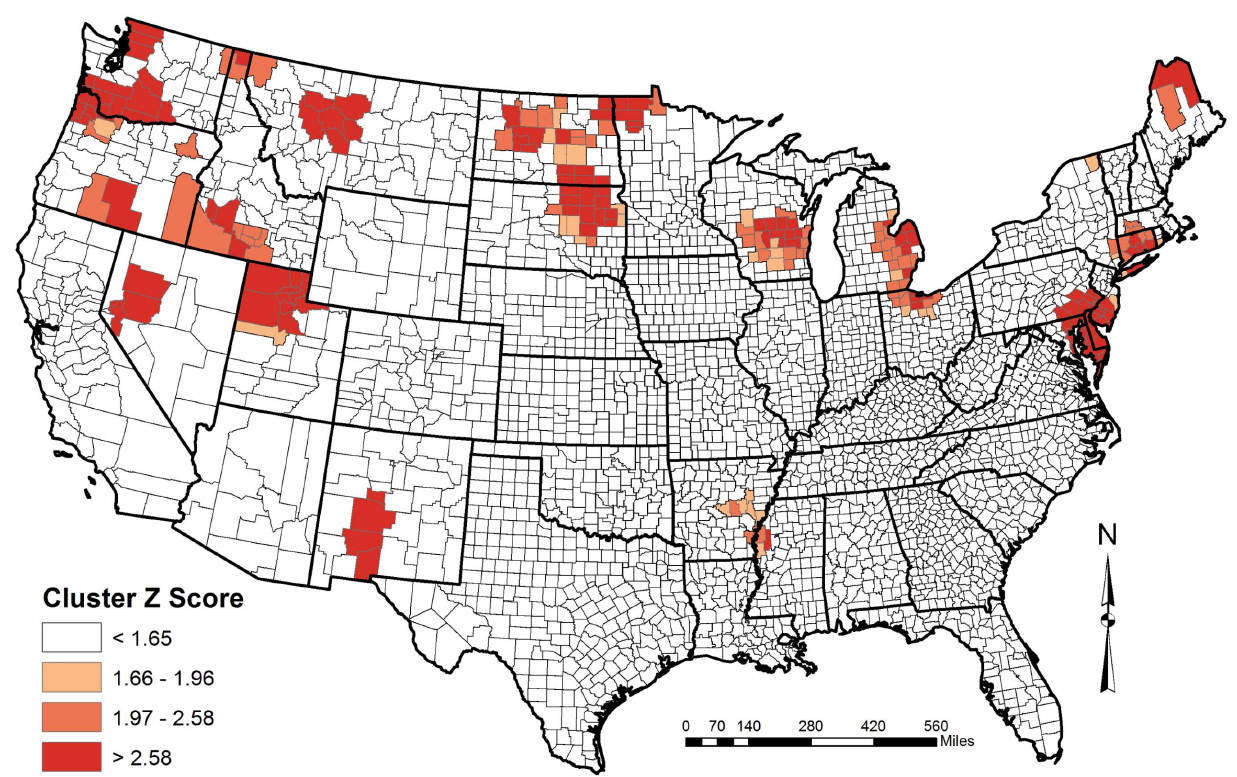
Figure 3. Continental scale map showing spatial clustering hot spots of avian influenza virus M gene positive wild birds. Z-score results from the Getis-Ord Gi* analyses: . 1.65=90% significant, 1.66–1.96=90%–95% significant, 1.97–2.58=95%–99% significant, . 2.58=99% significant.